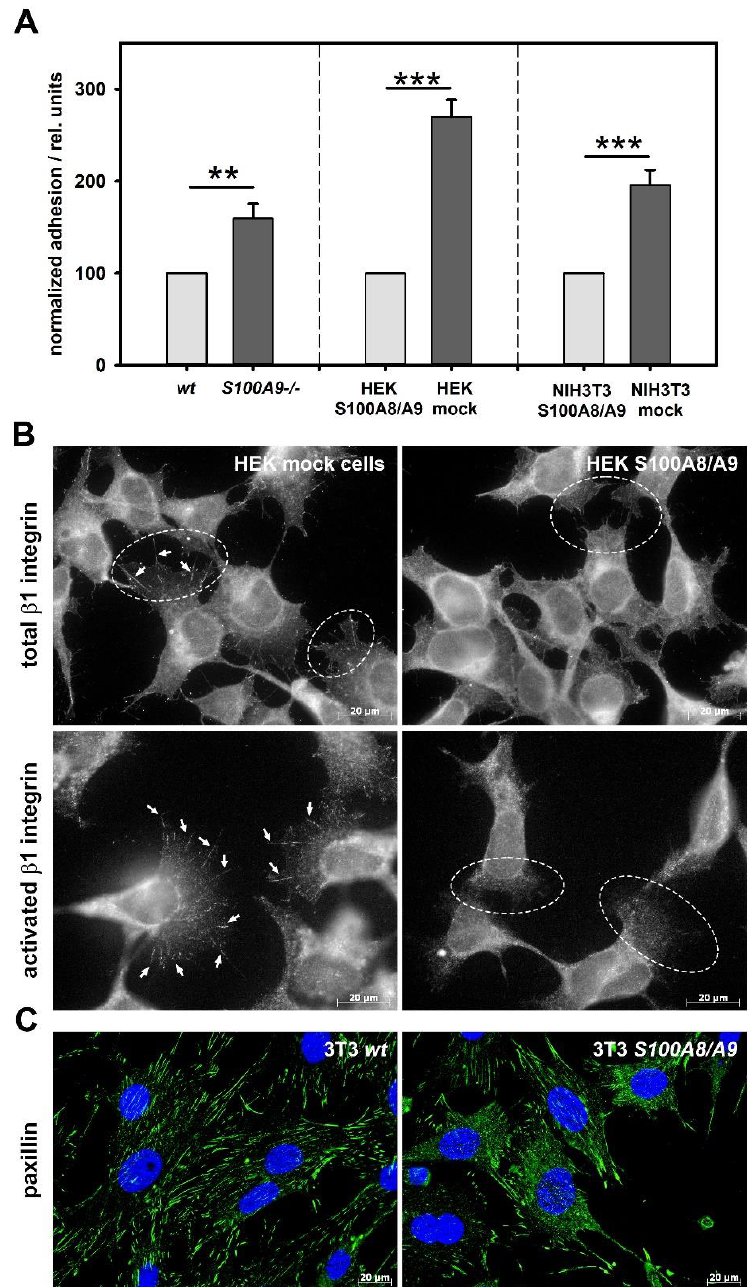
Figure 5. S100A8/S100A9 expression decreased cell adhesion and altered β 1-integrin signaling. ( A ) Influence of S100A8/S100A9 expression on cell adhesion in three different cell models. In all studied